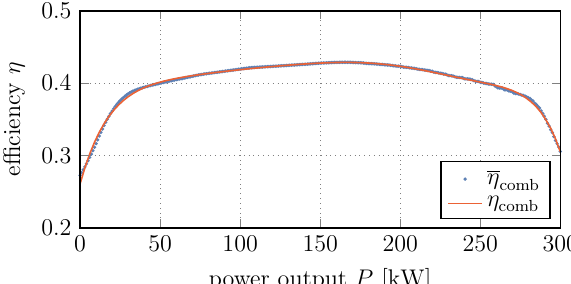
Figure 5. Averaged values (blue dots) and polynomial fit (red line) of combustion engine efficiency over desired power output using optimal gears for lowest brake specific fuel consumption (Figure